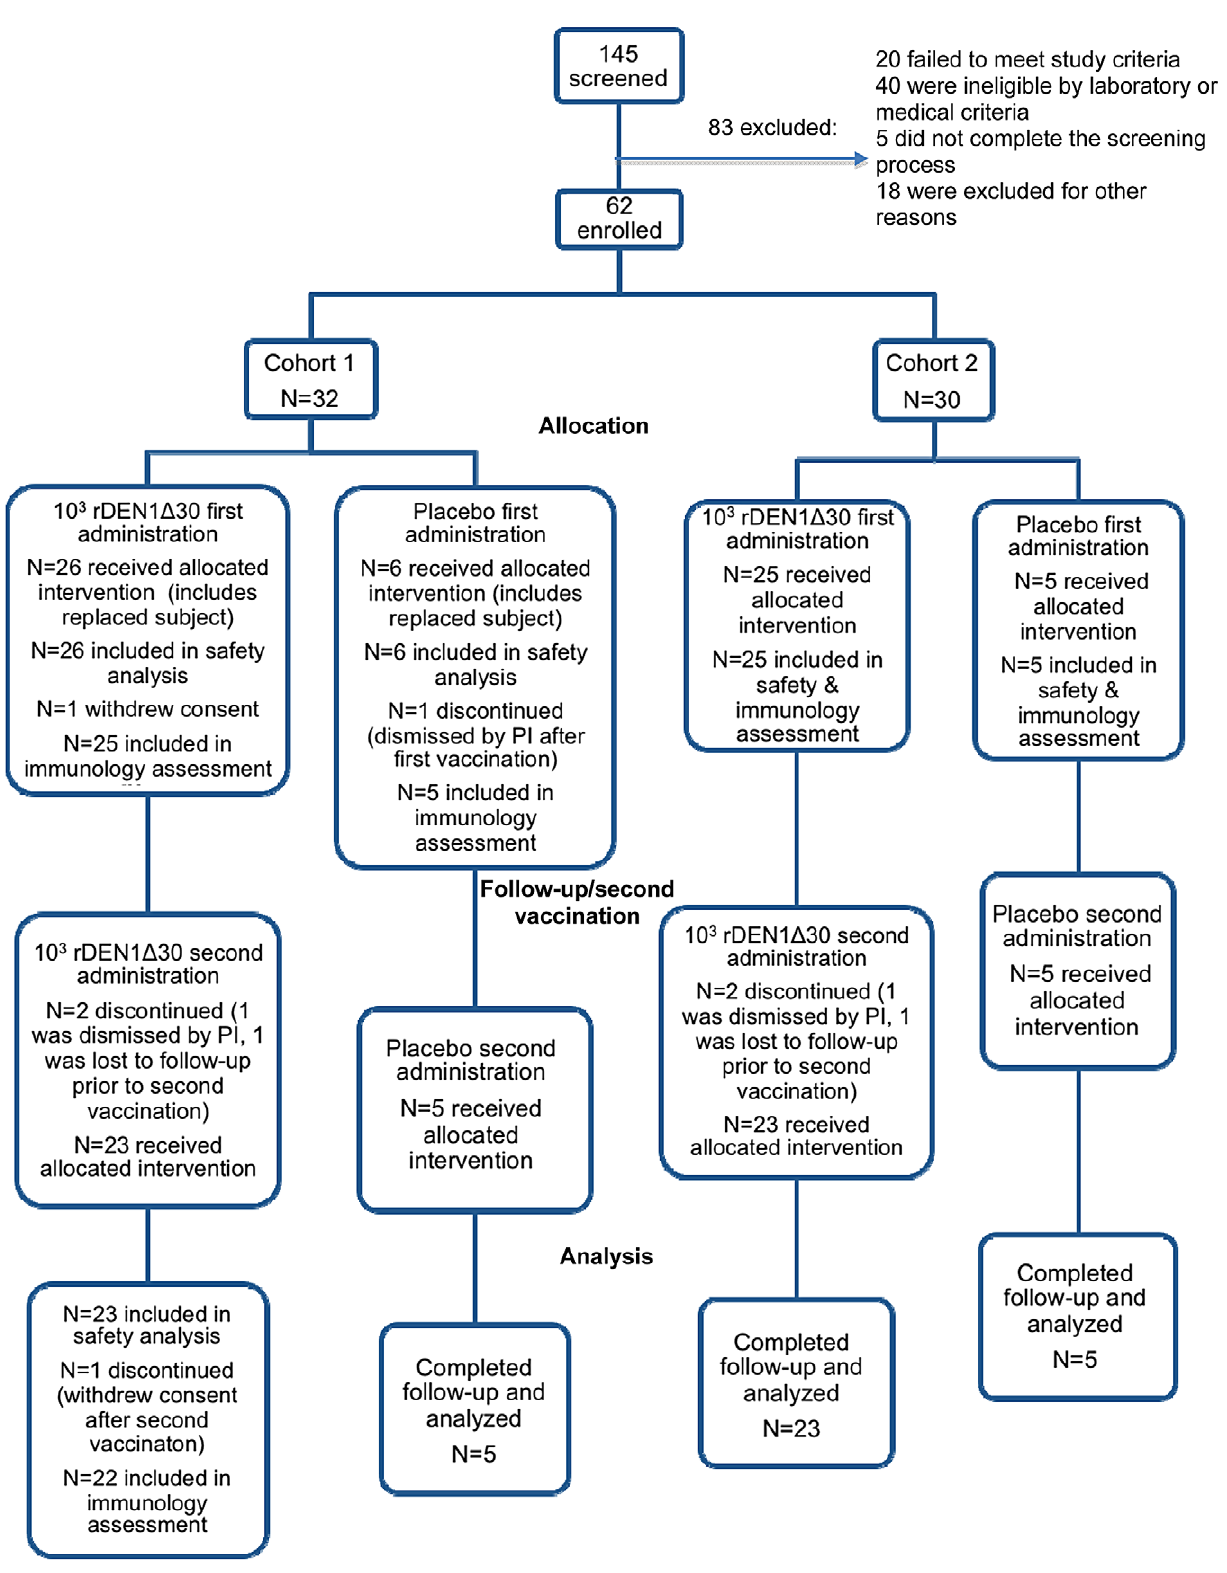
Figure 1. Screening, enrollment, vaccination, and follow-up summary of subjects enrolled in the trial evaluating rDEN1 D 30.